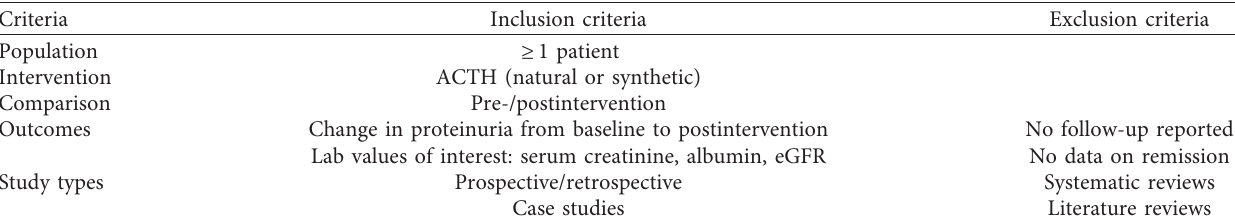
Figure 3: PRISMA flowchart showing studies considered for Table 3: A PICO table illustrating the systematic review criterion.